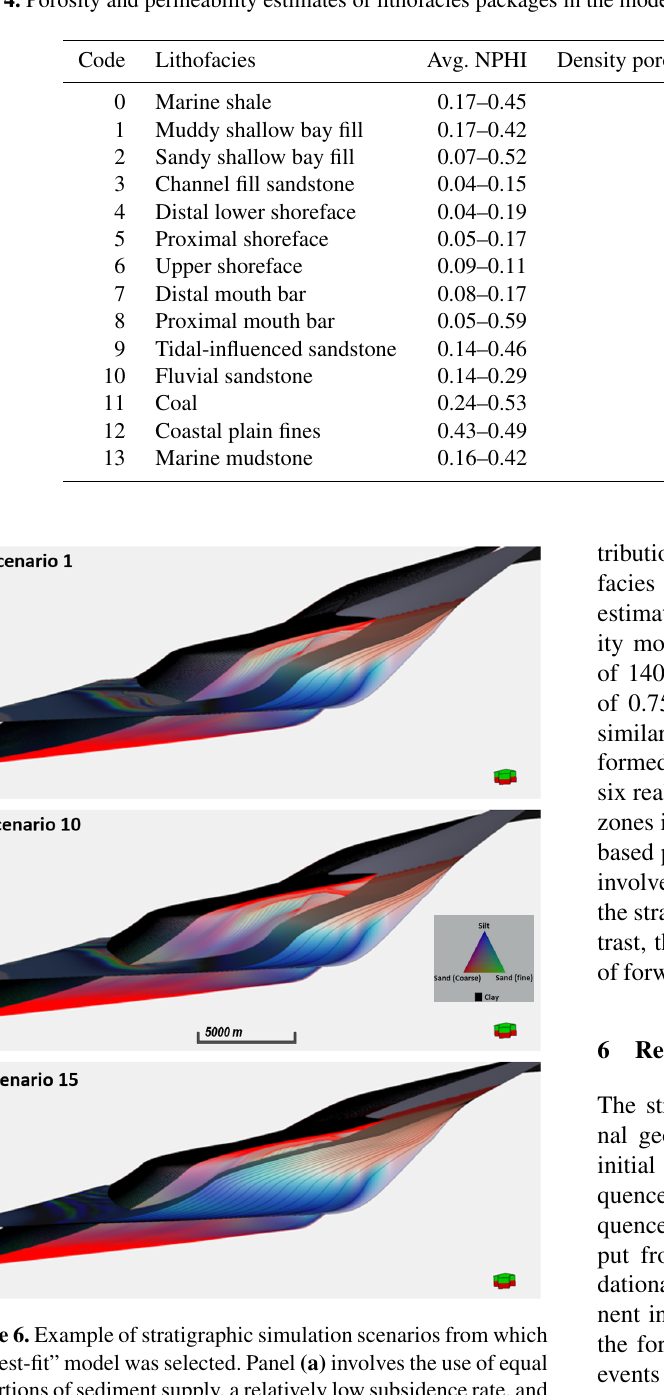
Table 4. Porosity and permeability estimates of lithofacies packages in the model area.